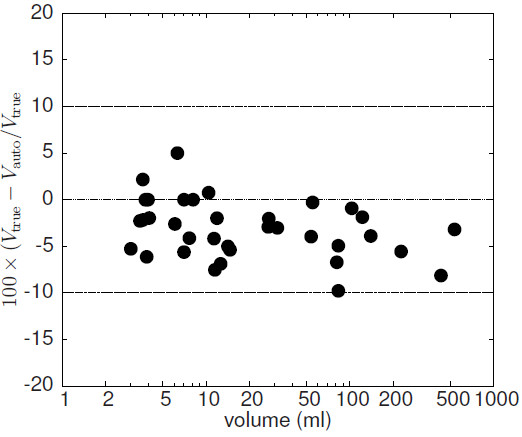
Fractional deviation of the automatically determined object volumes from the true values (at a noise level of FWHM = 5%). Note the logarithmic scale of the abscissa.